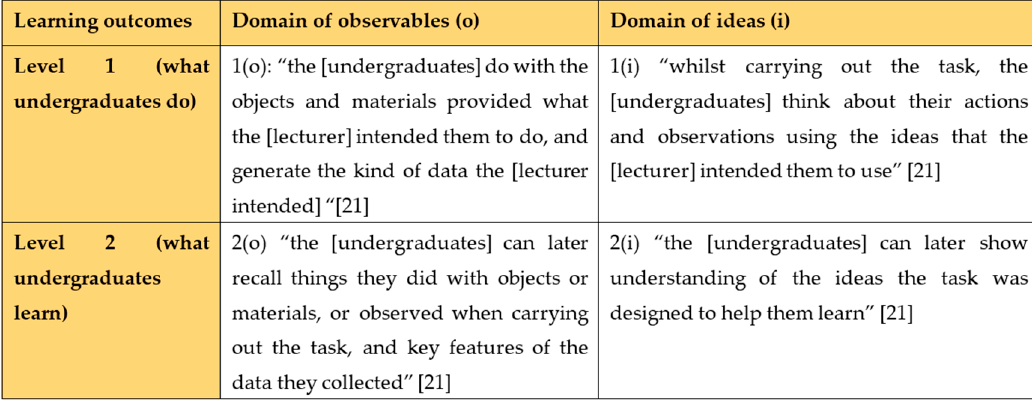
Figure 2. Analytical framework for the effectiveness of practical work adapting domains of knowledge by Tiberghien [20] and levels of effectiveness by Abrahams and Millar (2008) [11]. Modified table by Abrahams and Millar [21].